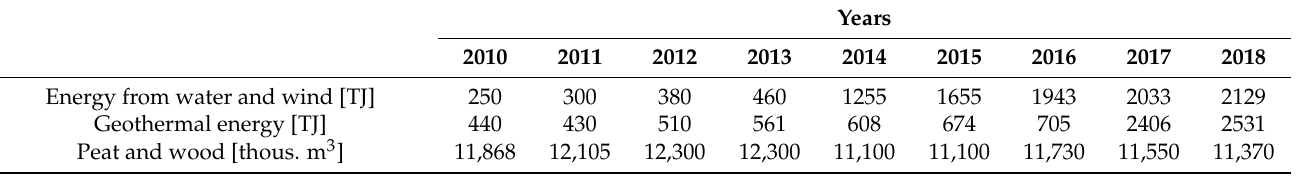
Table 1. Consumption of individual renewable energy carriers in households in Poland, in